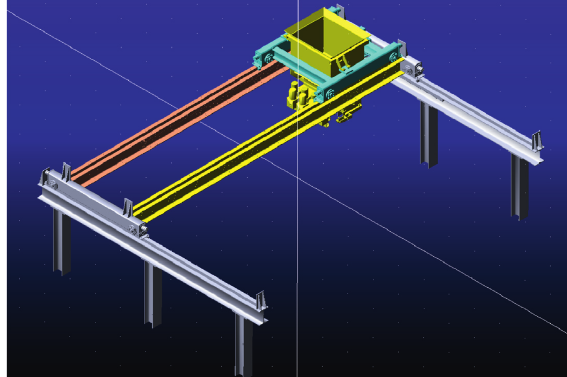
Figure 11: Adams model of heavy-duty concrete spreader.